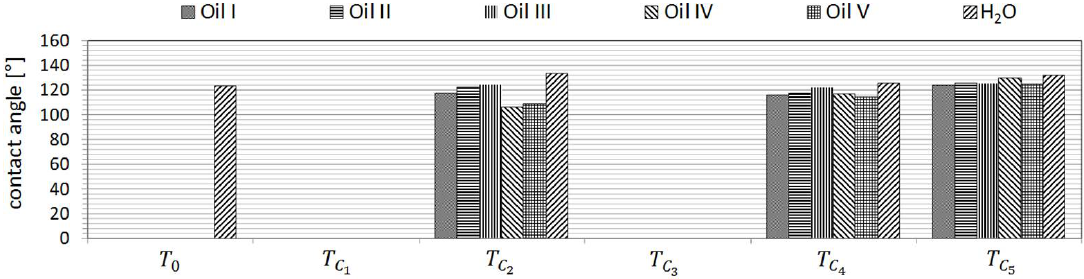
Figure 7. Measured contact angle θ between textiles and functional